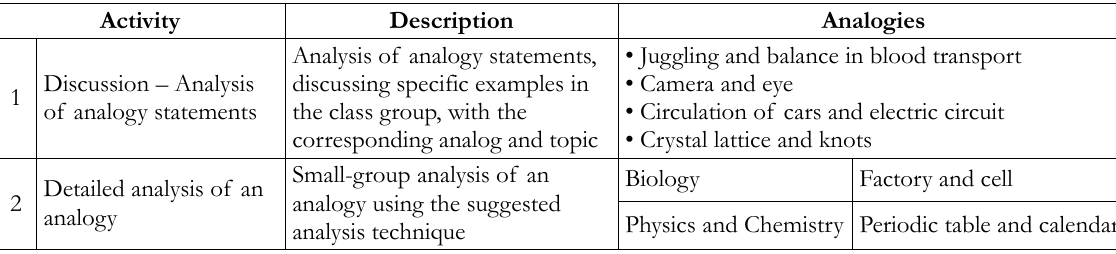
Table 3. Closing activities of session